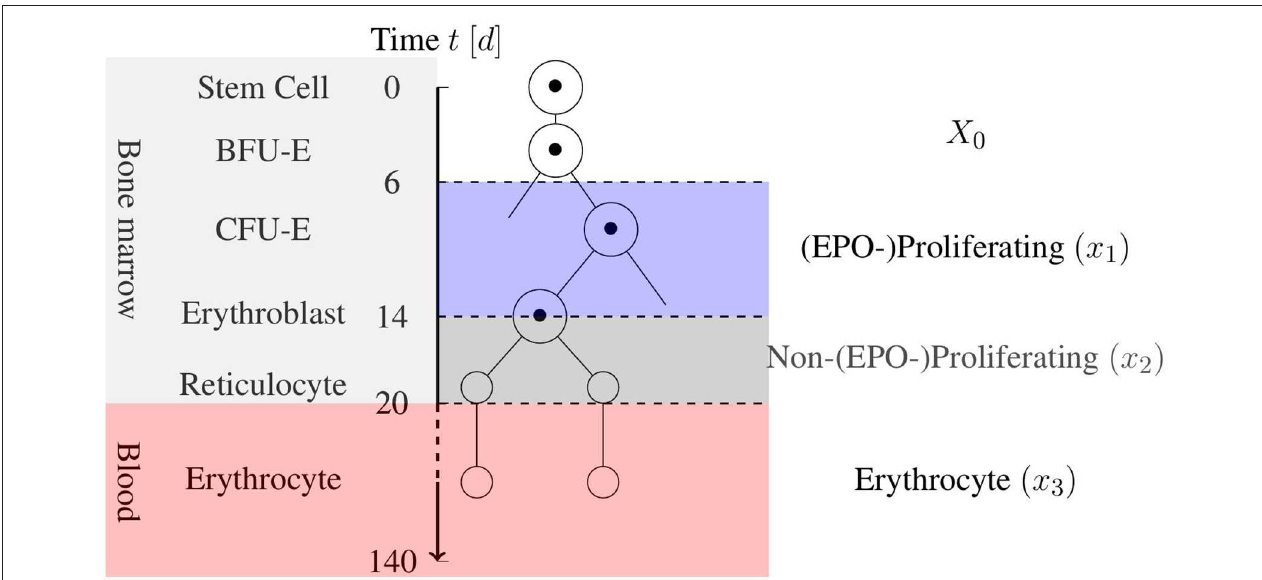
FIGURE 1 | Simplified schematic view of erythropoiesis. Certain cell stages over the age of the cell in days are displayed with a corresponding cell partition based on the model by Tetschke et al. (2018).